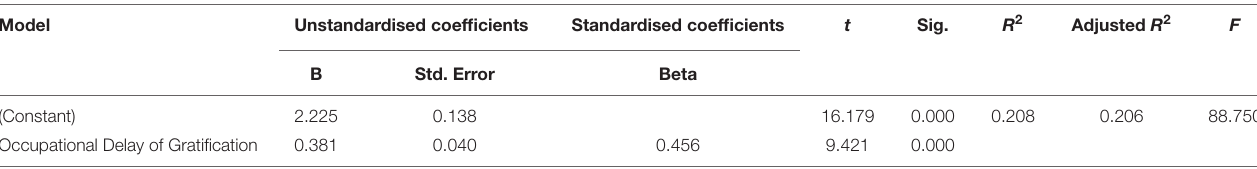
TABLE 10 | The influence of occupational delay of gratification on EI.